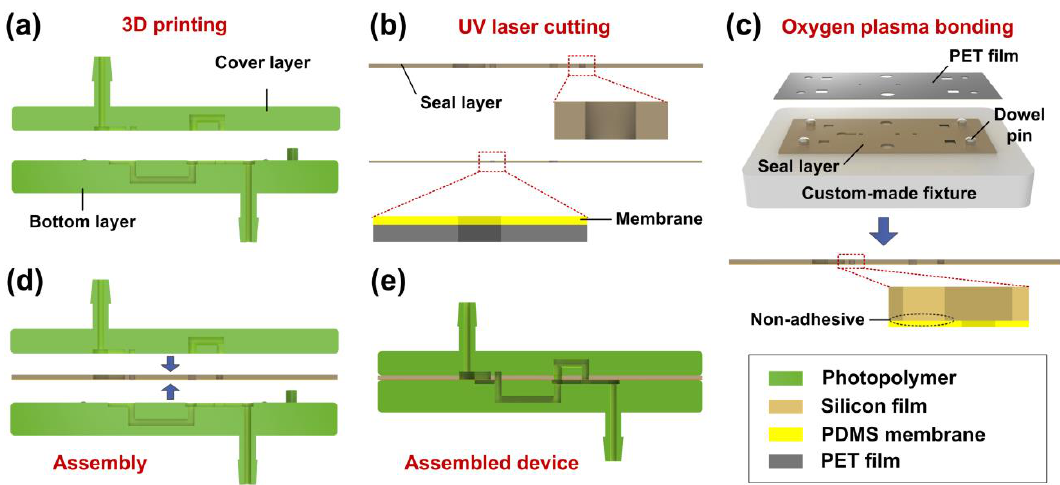
Figure 3. Schematic fabrication process of the microfluidic flow regulatory device. ( a ) 3D printing for the cover layer and the bottom layer of the device; ( b ) UV laser micromachining for the seal layer and the membrane; ( c ) Oxygen plasma treatment for the bonding of the seal layer and the membrane; ( d ) Assembling the device by stacking all the parts layer by layer; ( e ) The assembled device.